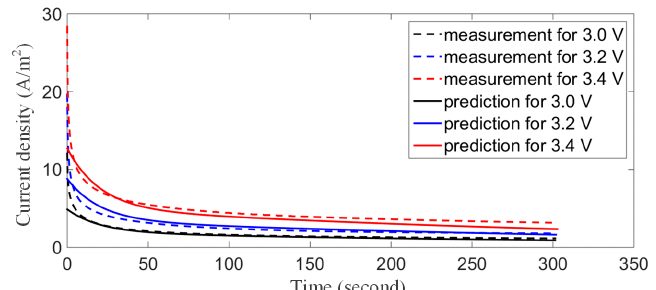
Figure 9. Measured electrodeposition currents and predicted currents by equivalent circuit for different applied potential. The mean absolute differences between measured currents and predicted currents for DC potentials 3.0, 3.2 and 3.4 V are 0.1776, 0.3037 and 0.5776 A/m 2 , respectively. The results demonstrate that the predicated currents and measured currents match well. Thus, the built equivalent circuit is justified.